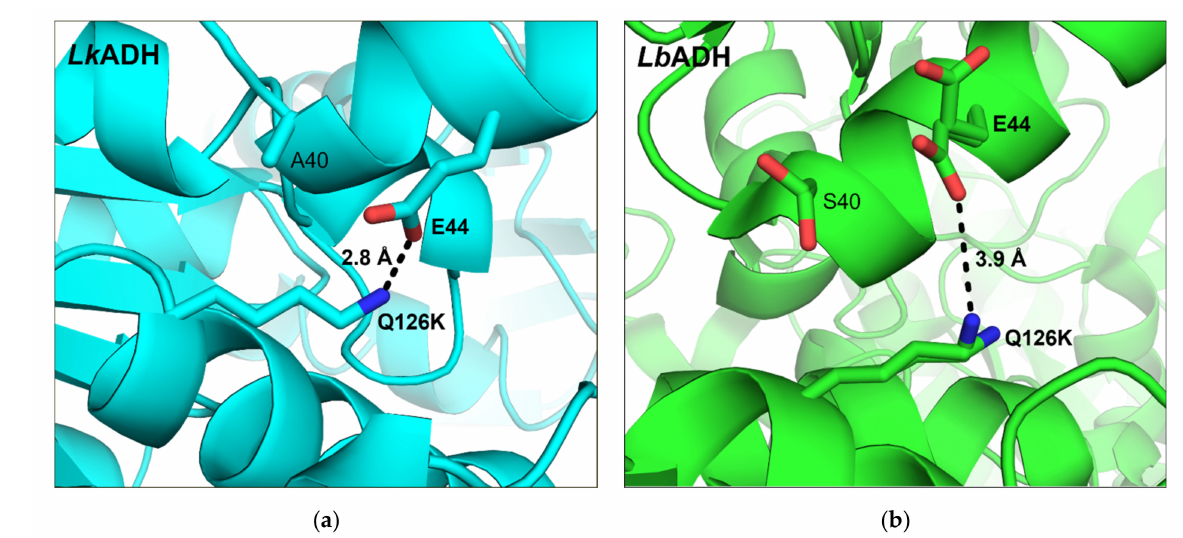
Figure 7. Illustration of crystal contact Q126K in ( a ) Lk ADH (PDB ID: 7P7Y) and ( b ) Lb ADH (PDB ID: 6Y0Z) with interaction partner E44. Distances were calculated using PyMOL (v.2.3;